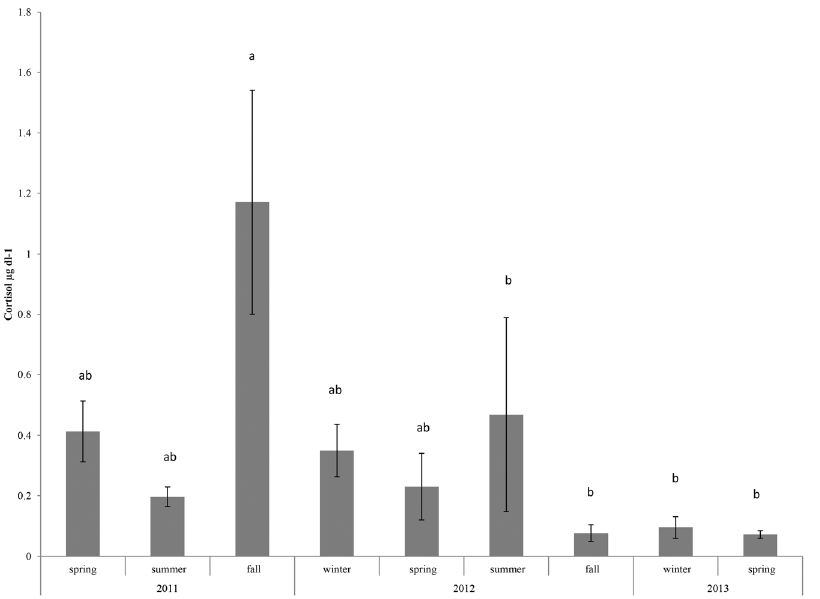
Figure 7. Average cortisol concentrations in blow ( ¡ SE) binned by season for 2011, 2012 and 2013. Letters indicate similarities and differences between seasons (i.e. all seasons marked with an ‘a’ are similar, but differ from those marked with a ‘b’). Cortisol values were higher during the fall of